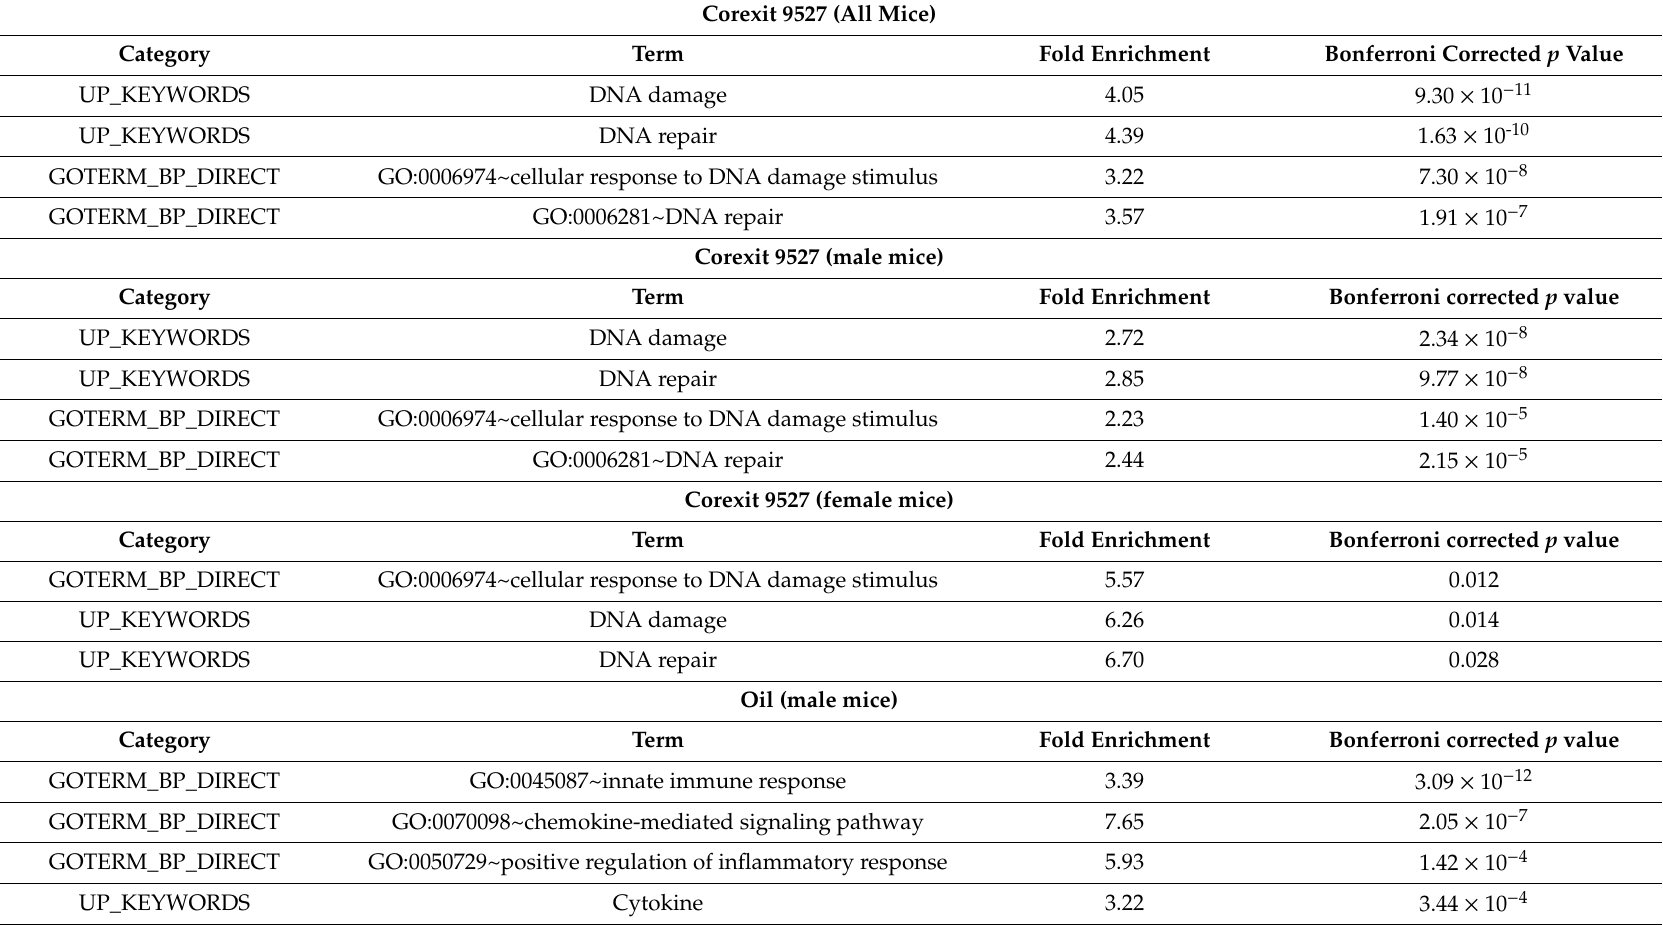
Table 2. DAVID gene set enrichment analysis of genes upregulated by Corexit 9527 or